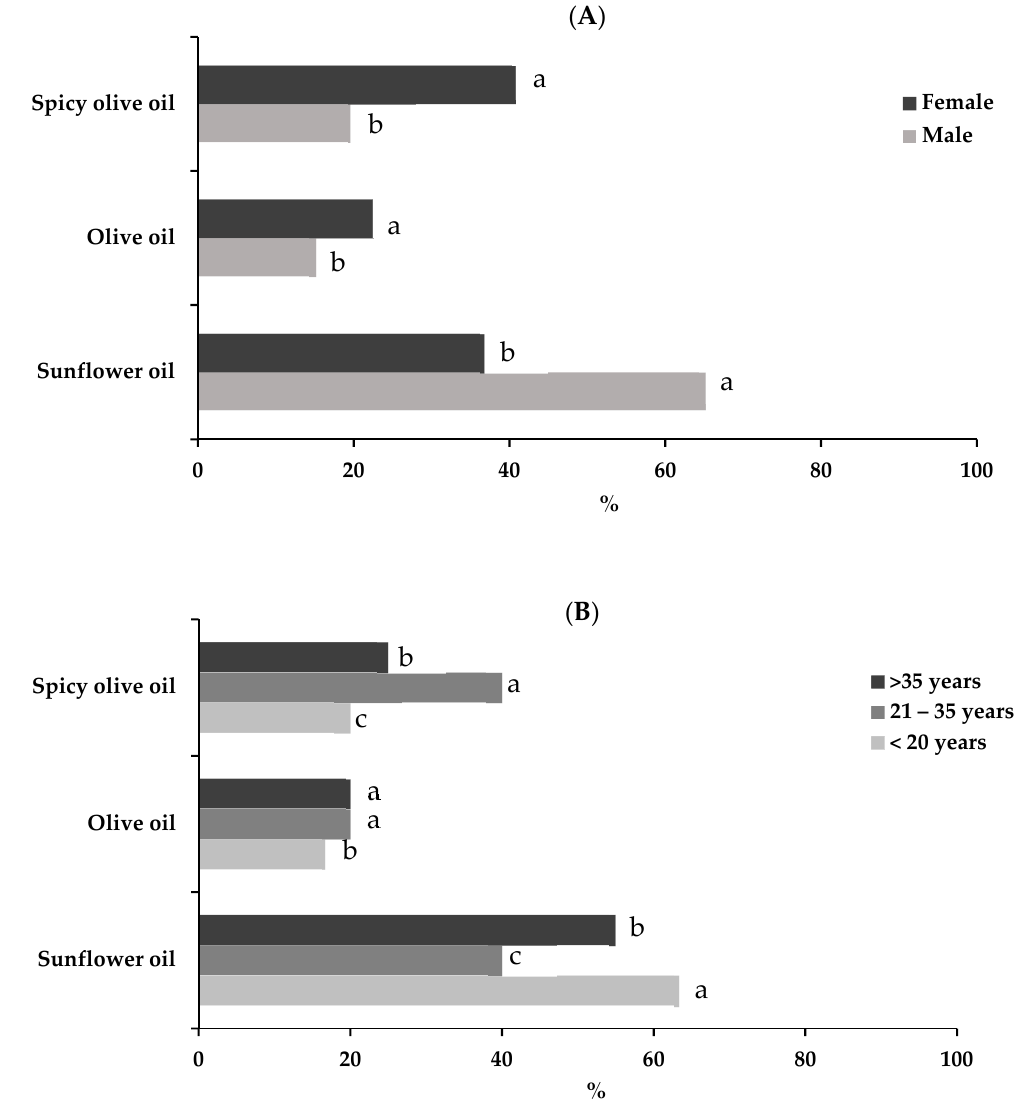
Figure 7. Mean score of preferences by gender ( A ) and age group ( B ). Different letters indicate significant differences ( p < 0.05) in each type of canned eels.